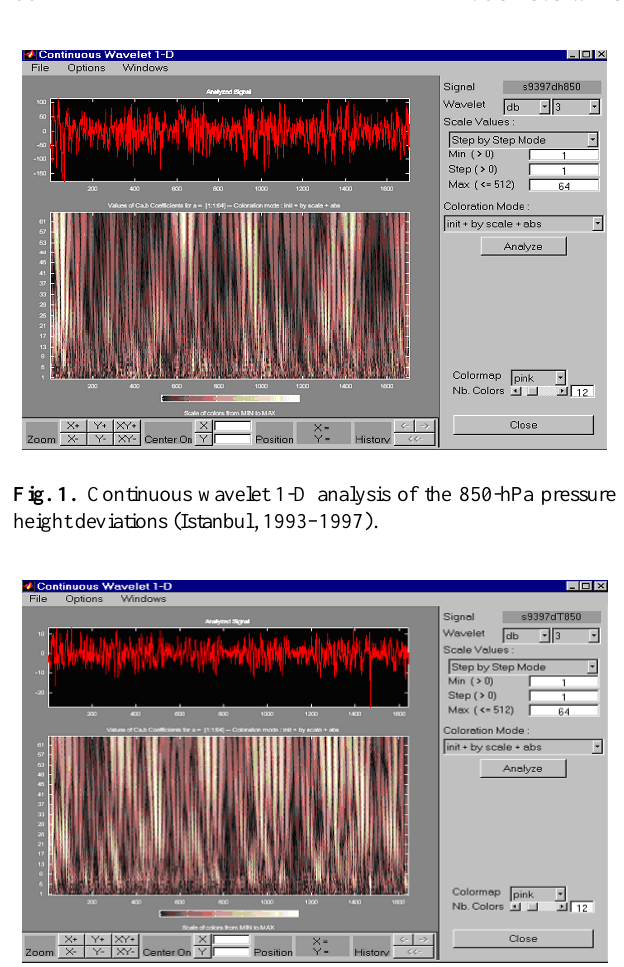
Fig. 2. Continuous wavelet 1-D analysis of air temperature devia- tions at the 850-hPa pressure level (Istanbul, 1993–1997).